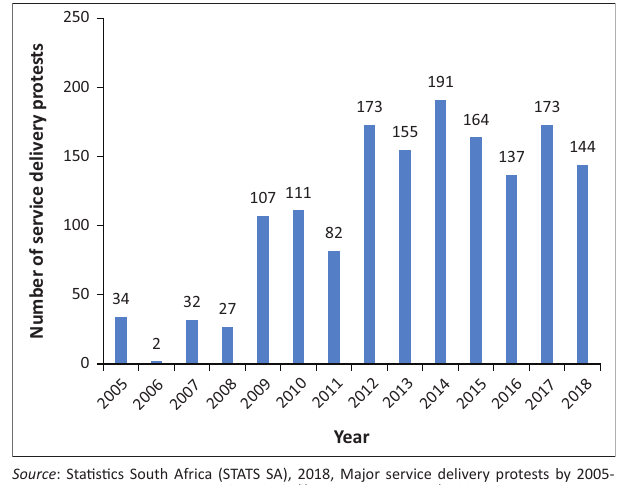
FIGURE 1: Major service delivery protests by